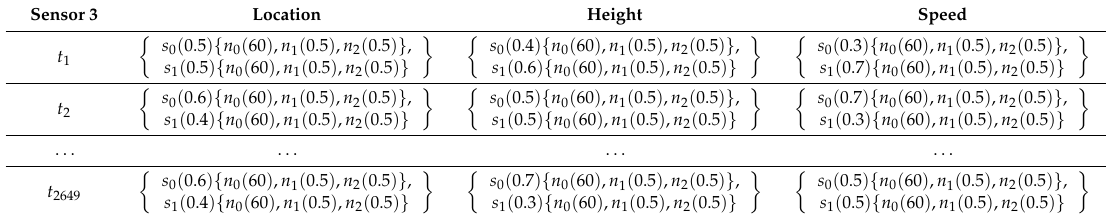
Table 5. Part of the individual evaluation matrix of sensor